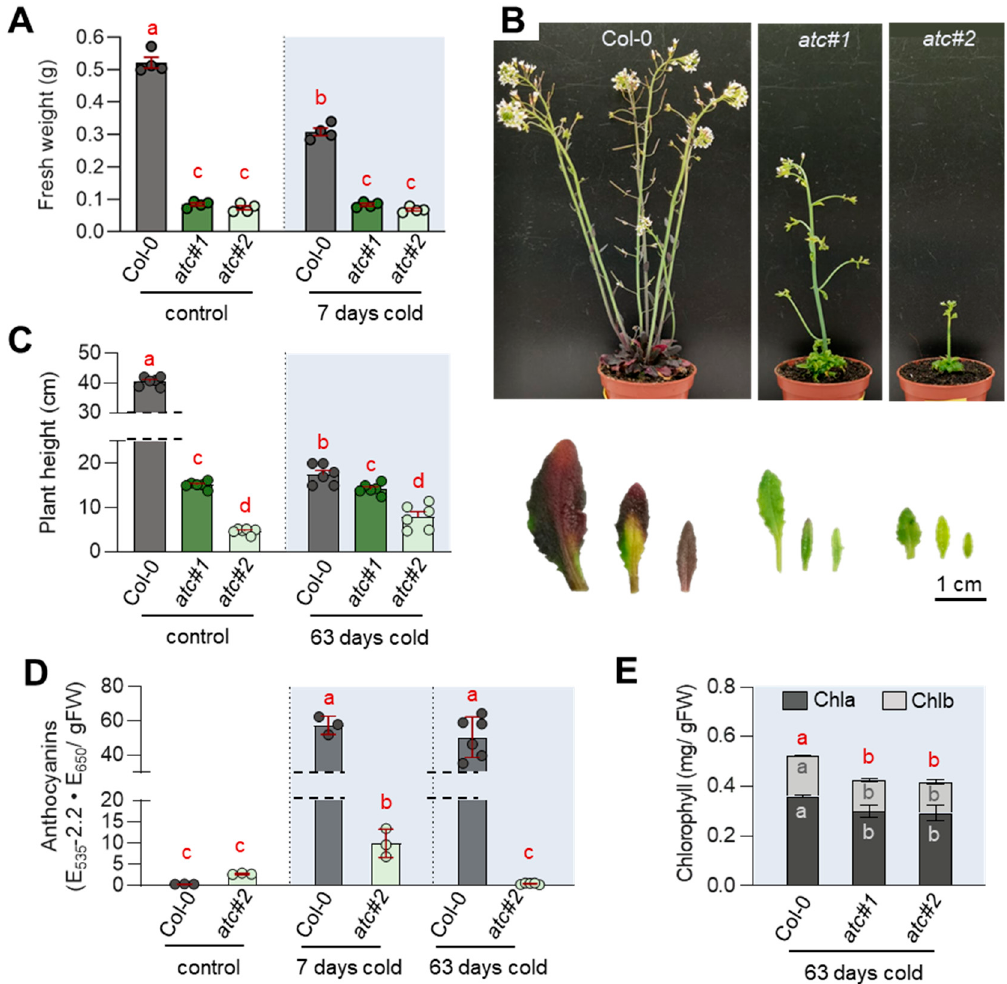
Figure 2. Cold acclimation and adaptation in Col-0 and ATC mutants. Plants were grown for three weeks at 22 °C before being transferred to 4 °C for the indicated timespan. Control plants were continuously grown at 22 °C for four weeks. ( A ) Fresh weight (n = 4) ( B ) phenotypical appearance after 63 days cold with closeup of leaves ( C ) plant height (n = 6) ( D ) anthocyanin contents of leaves (n = 3 for control and 7-day-old plants; n = 6 for 63-day-old plants) ( E ) chlorophyll contents (n = 4). Data points and means +/ − standard deviation are shown. Different letters denote significant differences according to a two-way ANOVA with post-hoc Tukey HSD testing ( p < 0.05).